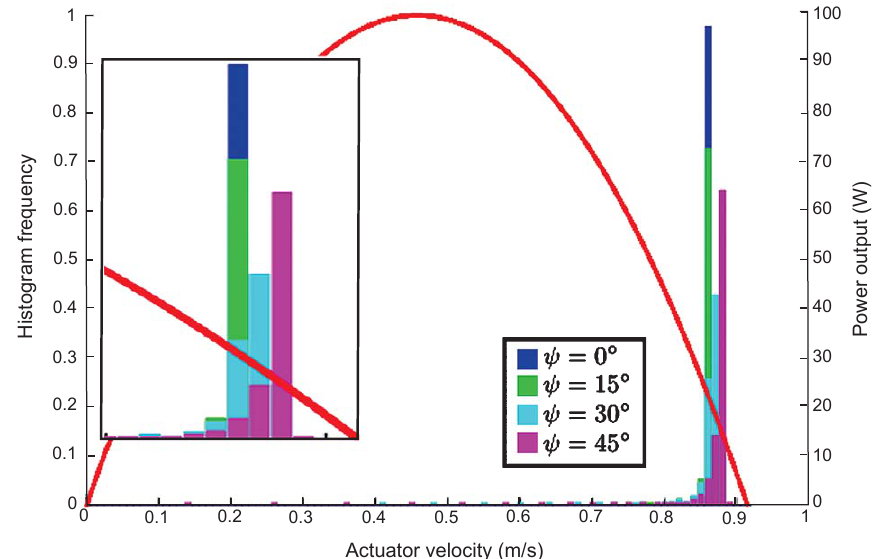
Fig. 8. The motor-powered climber’s shortening velocities at four different sprawl angles are represented by separate histograms. Actuator power output is overlaid in red. The inset (note the modified aspect ratio) shows the histogram in more detail, making more evident the shifts caused by sprawl angle.